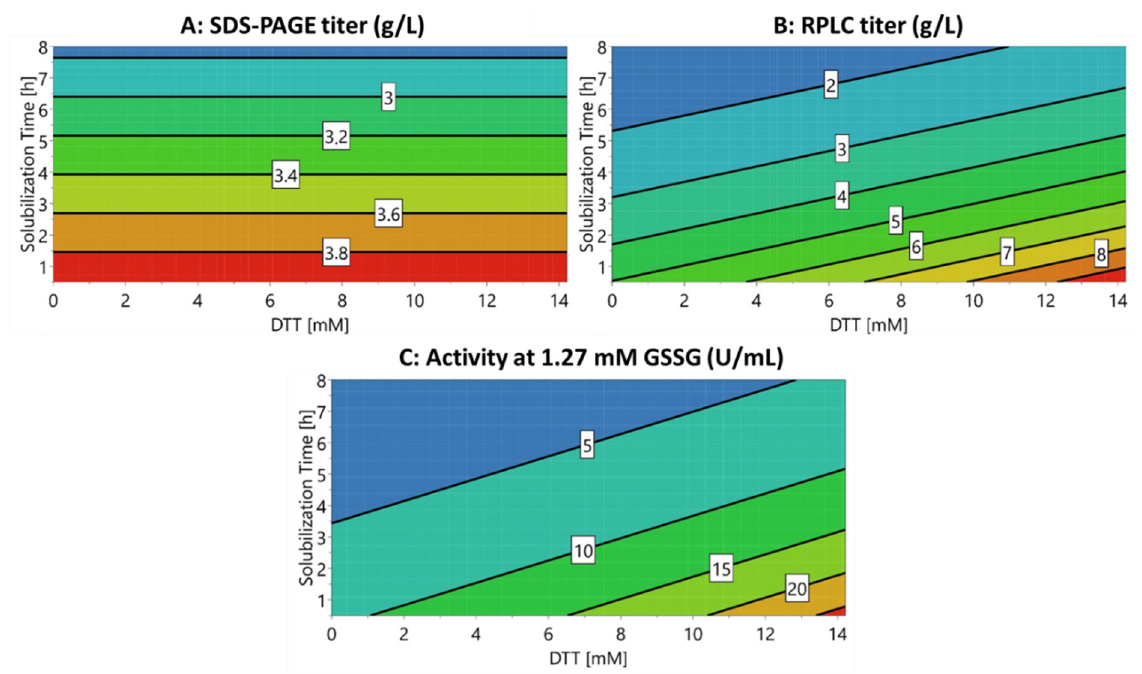
Figure 3. MODDE contour plots with the two factors of DTT concentration on the X-axis and the solubilization time on the Y-axis. The following responses are shown: ( A ) Monomeric HRP concentration in the solubilizate (g/L) analyzed using SDS-PAGE. ( B ) Monomeric HRP concentration in the solubilizate (g/L) analyzed using RPLC. ( C ) Effect of the different solubilization conditions on the volumetric activity (U/mL) after refolding, which was performed at constant GSSG conditions of 1.27 mM.